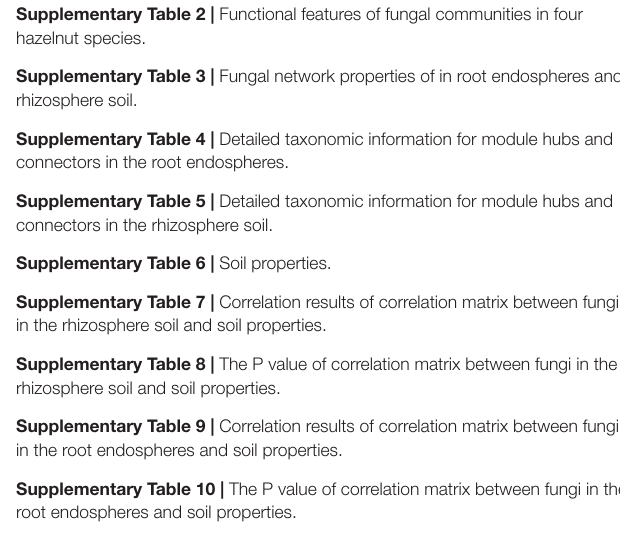
Supplementary Table 1 | Fungi community diversities indices.